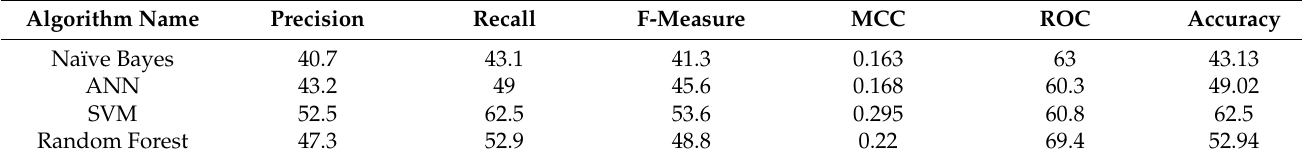
Table 10. Comparison among classification algorithms using 10-fold cross-validation testing to predict the total recovery cases.